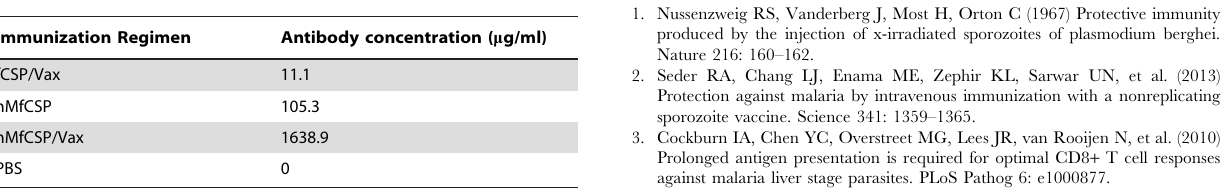
Figure S1 DNA sequence of pMCSP plasmid. The IP-10 leader sequence: red; MIP3 a : blue; CSP: black; Myc-Hisx6 tag: orange; Multiple cloning site/spacer: green. Translation start codon and stop codon are marked with boxes. (TIF) Figure S2 DNA sequence of phMfCSP plasmid. TPA leader sequence: red; hMIP3 a : blue; fCSP: black; Myc tag: orange; Multiple cloning site/spacer: green. Translation start codon and stop codon are marked with boxes. (TIF)